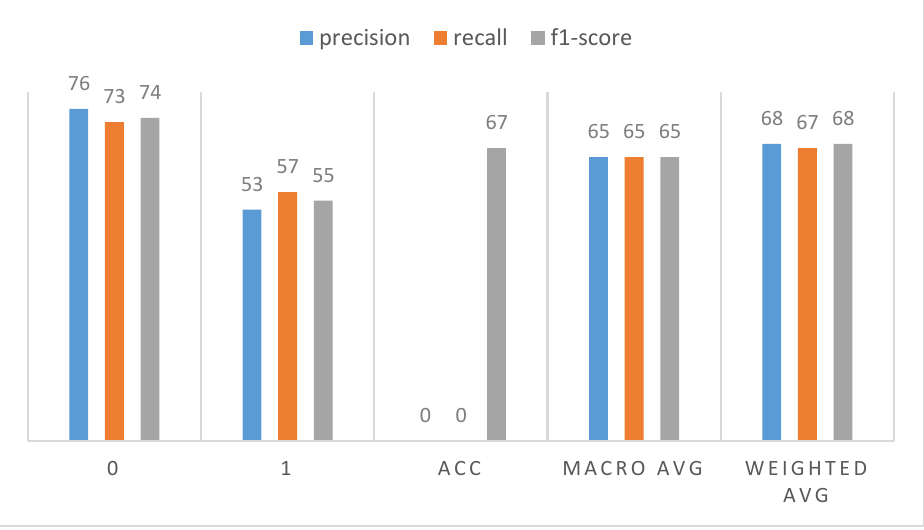
Figure 15. Summary of results for a testing dataset equal to 60% and training dataset of 40%. With an increase in the percentage for the test dataset size to 60%, a significant decrease was noticed in Figure 15 for class 1, in contrast to the graph of Figure 14. The other parameters remained constant.